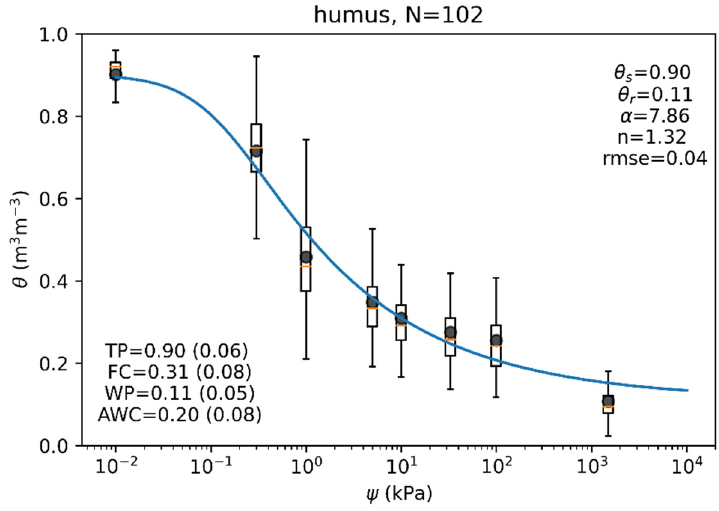
Figure 2. Water retention curve and mean statistics of the organic humus layer overlying the mineral soil. TP, FC and WP are the total porosity, field capacity and wilting point, and AWC is the available water capacity (mean (std), m 3 m − 3 ). The boxplots show variability among samples ( N = 102); the median is shown by an orange line, boxes are IQR and whiskers are 1st/99th percentiles. The MvG water retention curve was fitted to the mean (gray dots) of observations and the parameters shown in upper right corner. The rmse is the root mean squared error.